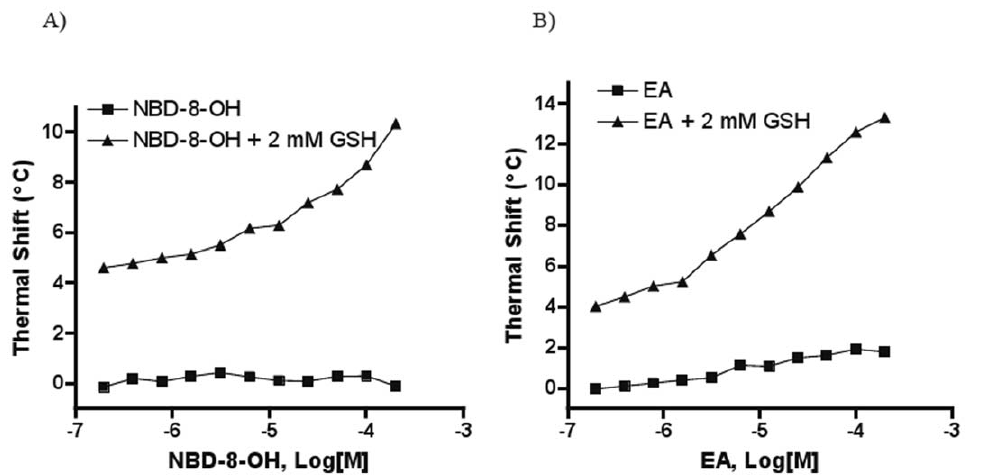
Figure 5. Thermal shift concentration response curves using Sj GST in the absence and presence of GSH for the conjugate-formers NBD-OH (A) and ethacrynic acid (EA, panel B). Thermal shifts represent the differences in T m between vehicle control and compound- containing samples, respectively.